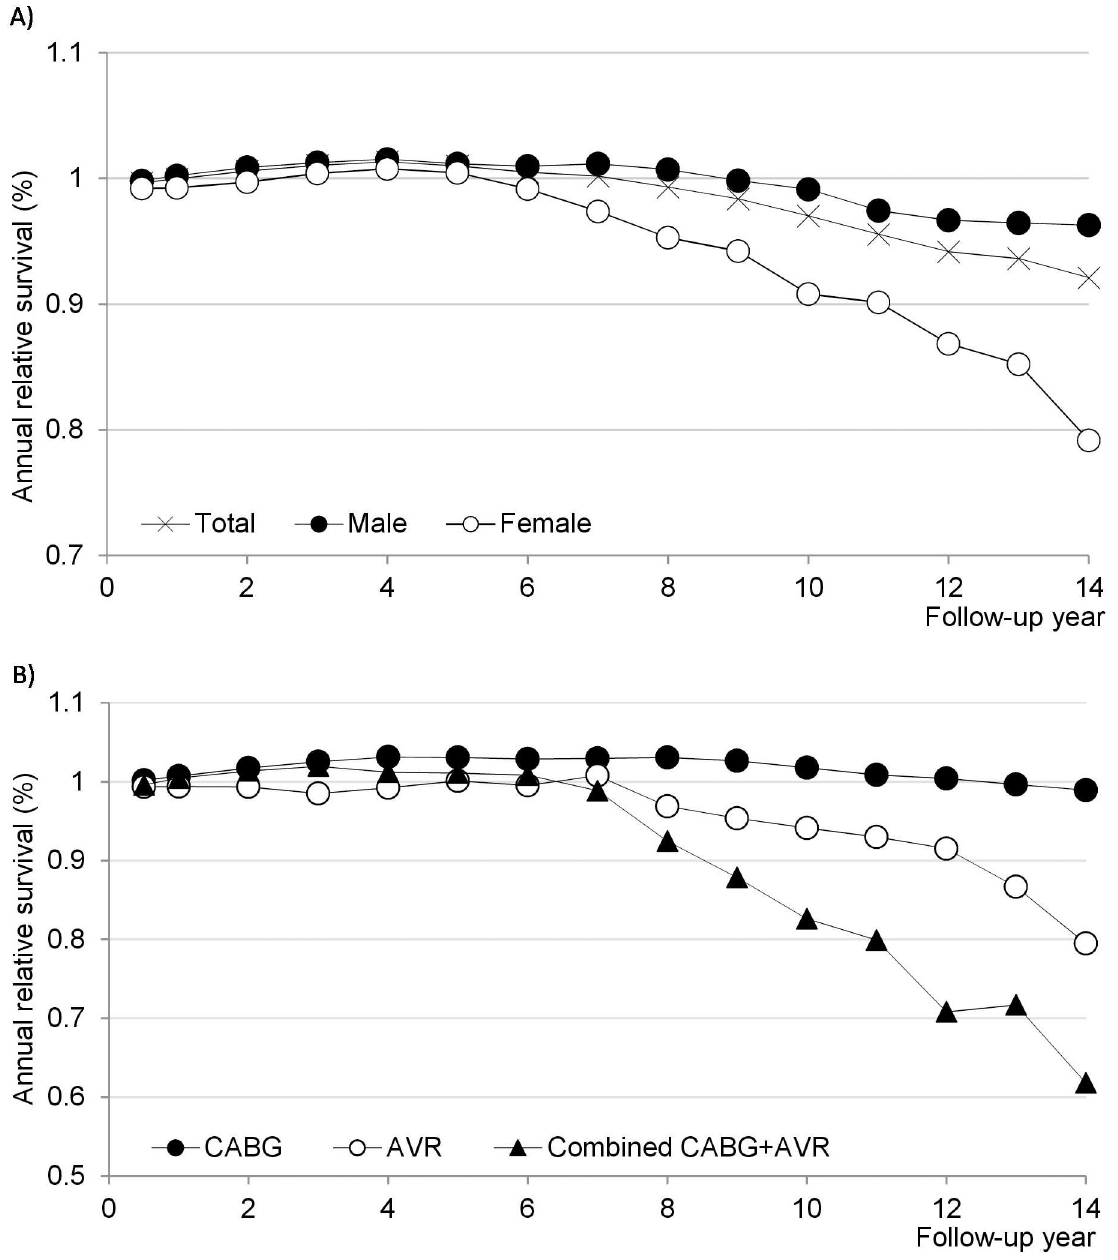
Fig 3. Annual relative survival amongst cardiac surgery patients surviving the first 30 postoperative days. A) Shown in total (n = 8,380) and separatelyfor males (n = 6,244) and females (n = 2,136). B) Shown for patients undergoing isolated coronary artery bypass grafting (CABG, n = 5,593), isolated aortic valve replacement (AVR, n = 699) and combinedCABG and AVR (n = 809). A relative survival > 1 indicates a survival advantagein the study